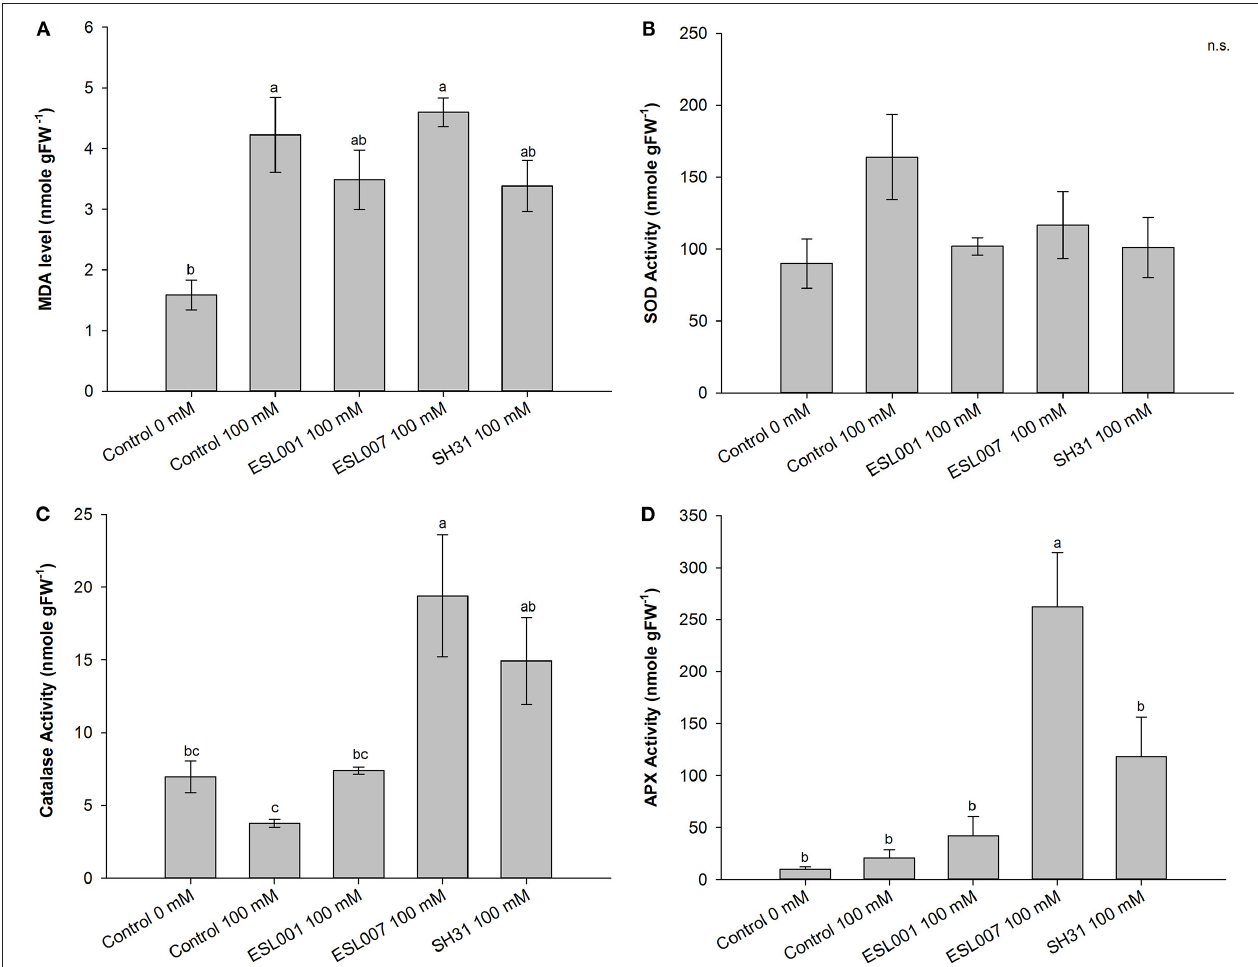
FIGURE 3 | Effects of ESL007, SH31 and ESL001 strain inoculation on the level of (A) MDA and in the activities of the antioxidant enzymes (B) superoxide dismutase (SOD), (C) catalase (CAT), and (D) ascorbate peroxidase (APX) in lettuce. Different letters indicate statistical differences at p <